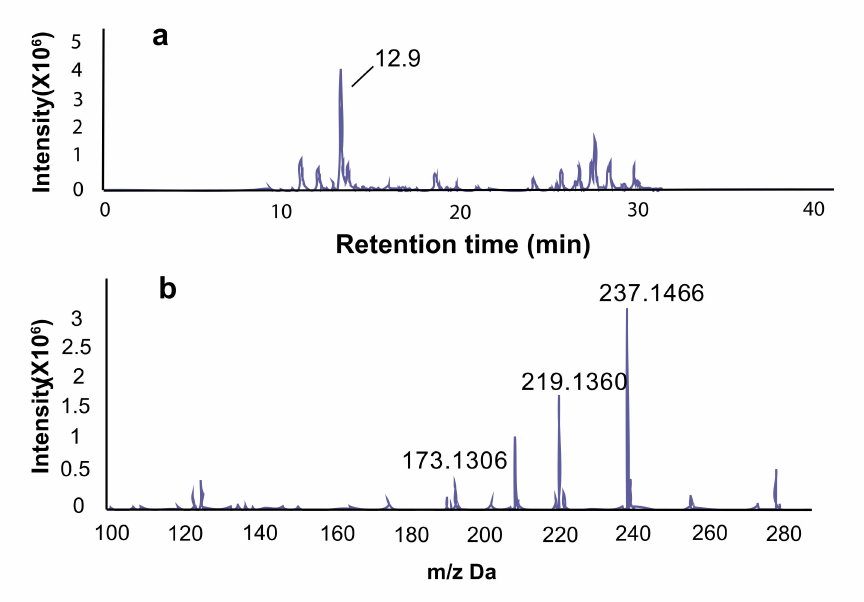
Figure 4. Isolation and purification of active compounds. ( a ) The active fraction 3 was subjected to LC-MS. The significant component is at 12.9 m in the LC; ( b ) the exact m / z from the significant component was 237.1466 ([M + H] + , C 14 H 21 O 3 ; calculated 237.1485), 219.1360 [M + H-H 2 O] + , 173.1306 [M + H-2 × H 2 O-CO] + .